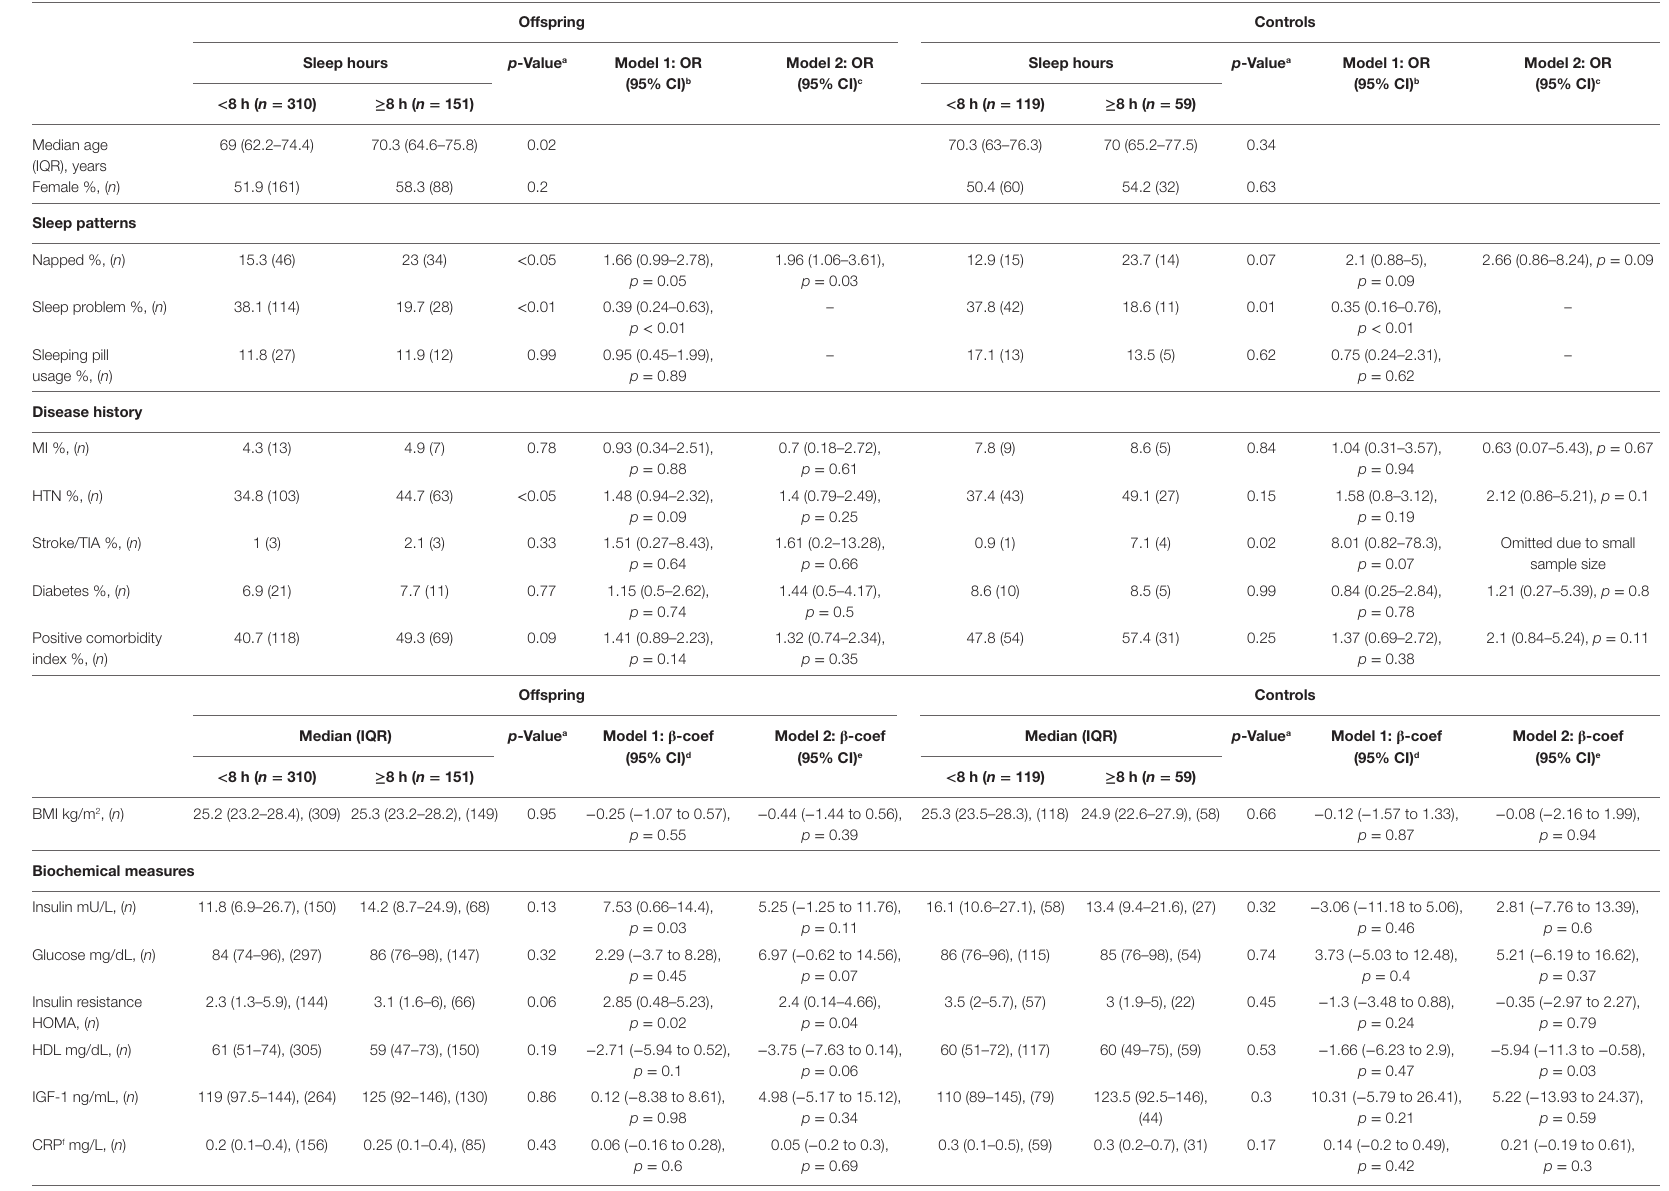
TaBle 3 | Associations between sleep duration and disease or biochemical profile for offspring and